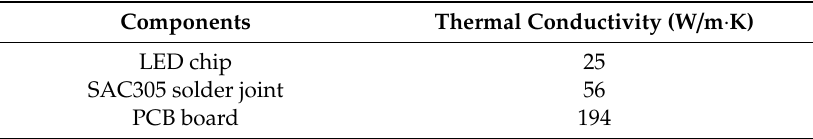
Table 7. Thermal conductivities of components used in the 3D model.